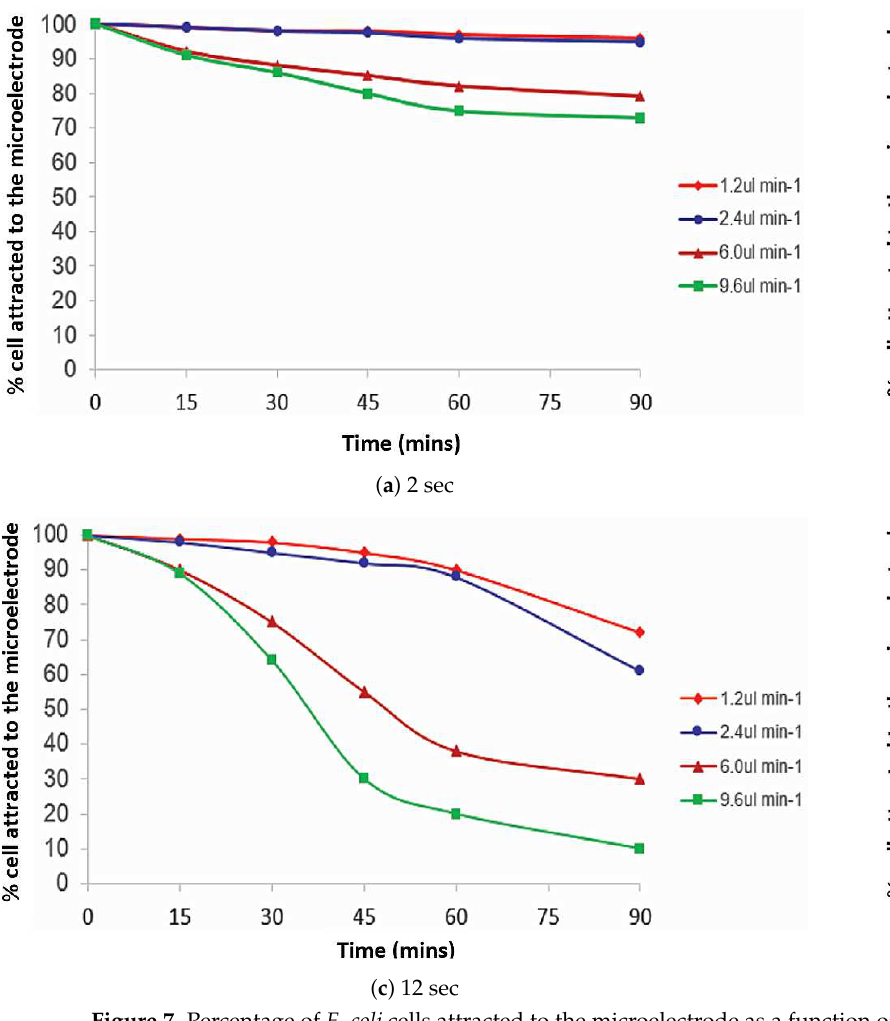
Figure 7. Percentage of E. coli cells attracted to the microelectrode as a function of time, comparing the pulsing time applied with the variation of flow